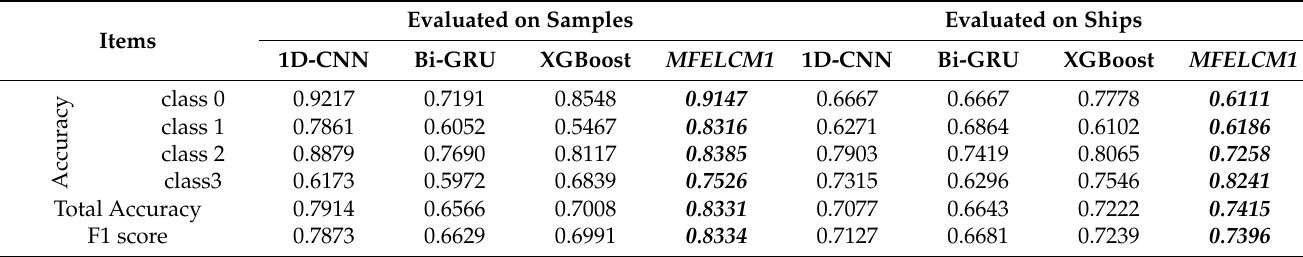
Table 16. Parameters of Random Forest2 (in MFELCM2).